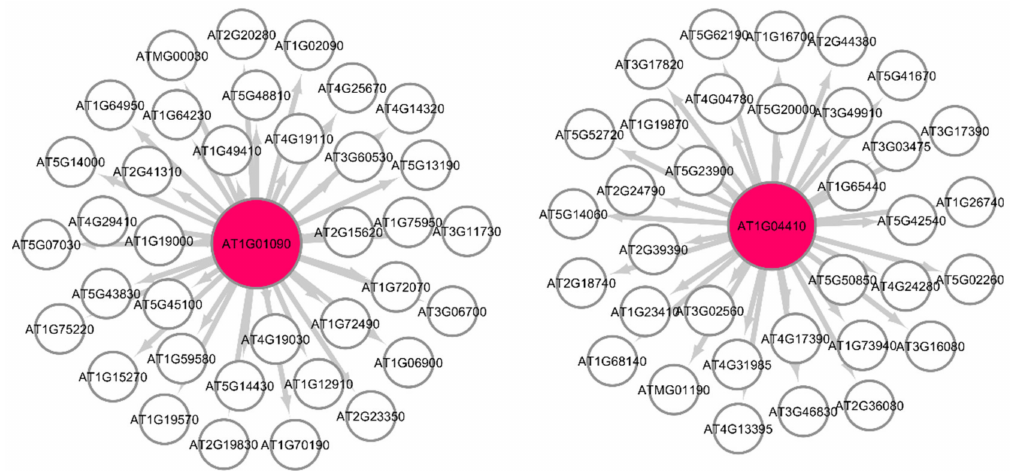
Figure 6. Gene regulatory sub-graph for the catabolic process in Arabidopsis thaliana Col-0 mutant phyD in spaceflight total light environment. The hub genes are the red circles representing the strong interactions with differentially expressed genes. The target (authority) genes are white